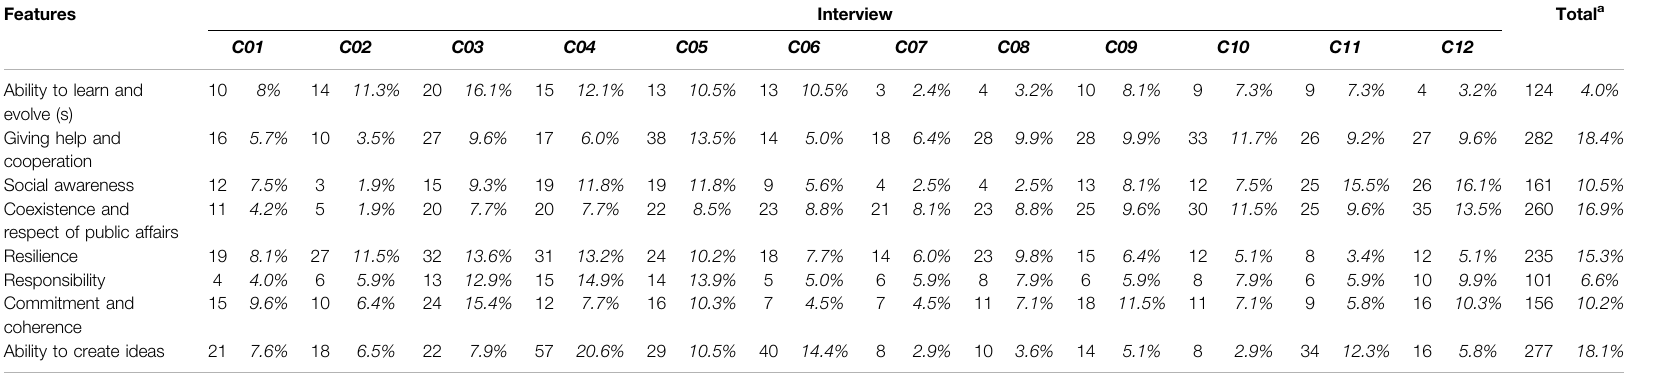
TABLE 5 | Social features